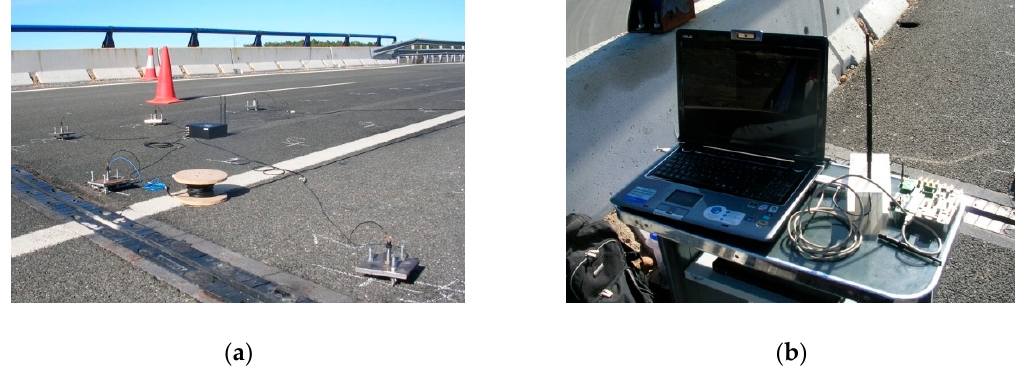
Figure 4. The wireless sensing system: ( a ) One of the client units; ( b ) server.